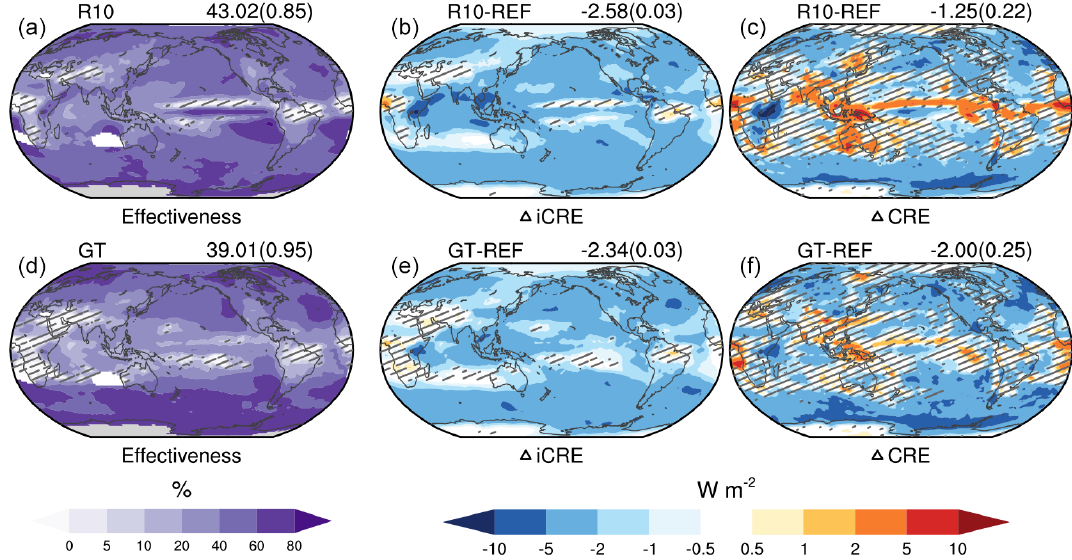
Figure 7. Similar to Fig. 4 but for (cid:49) iCRE (b, e) , (cid:49) CRE (c, f) , and cirrus seeding effectiveness (a, d) from the R10 (a–c) and GT (d–f)